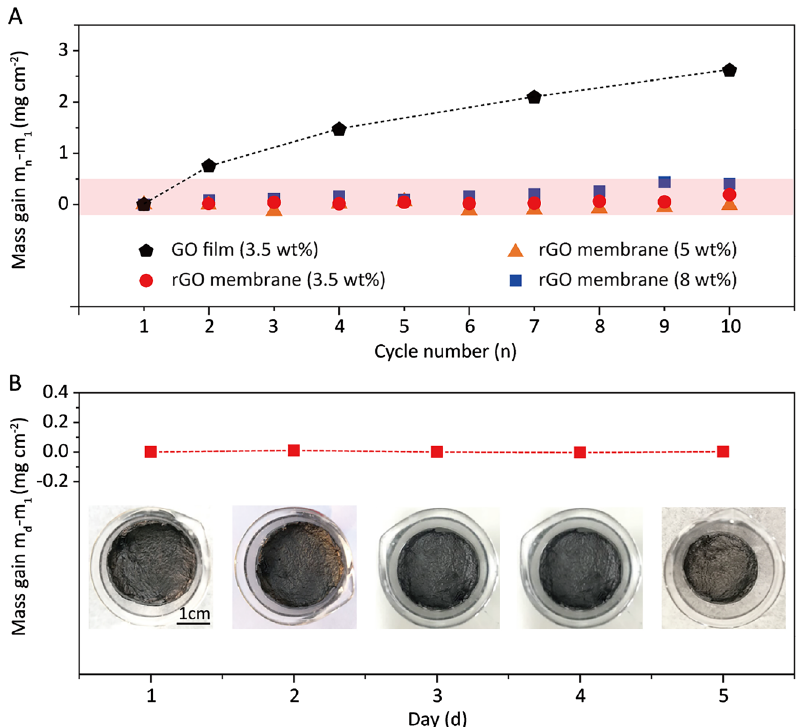
Figure 4: Salt-rejecting ability of the reduced grapheneoxide(rGO)membraneduringsolar